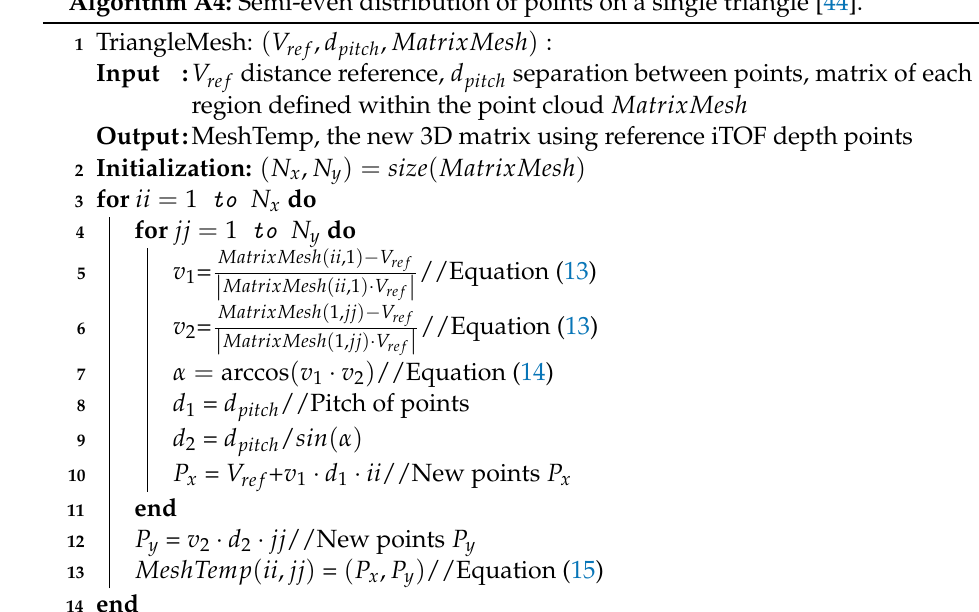
Algorithm A4: Semi-even distribution of points on a single triangle